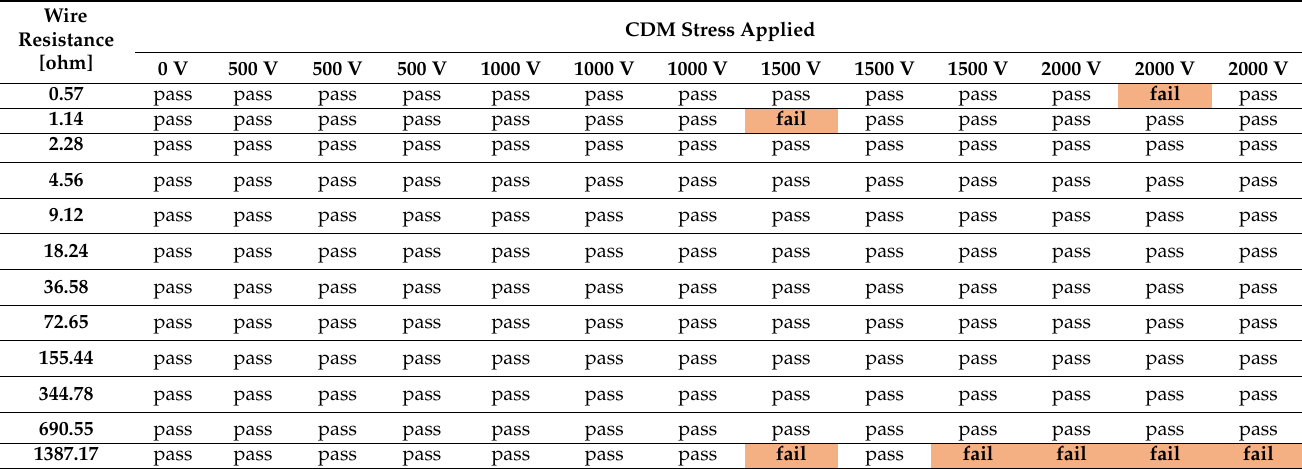
Table 2. Results of post-CDM stress